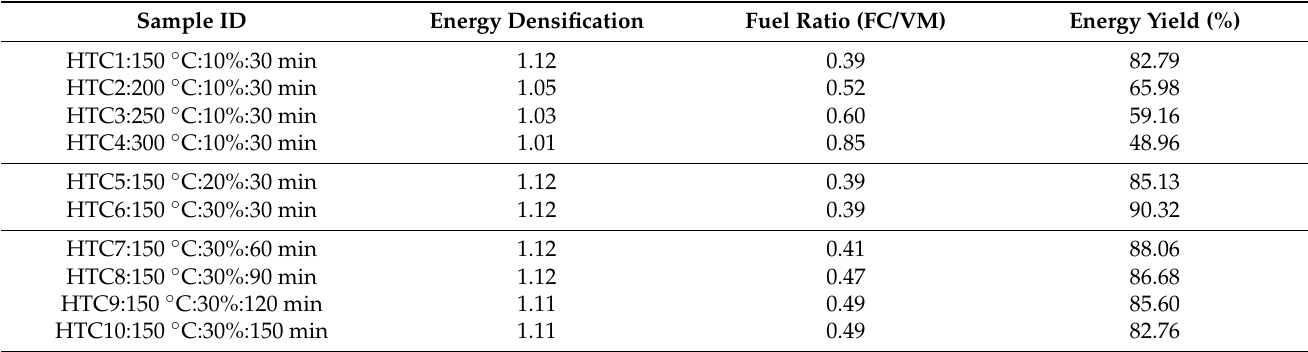
Table 4. Fuel characteristics of